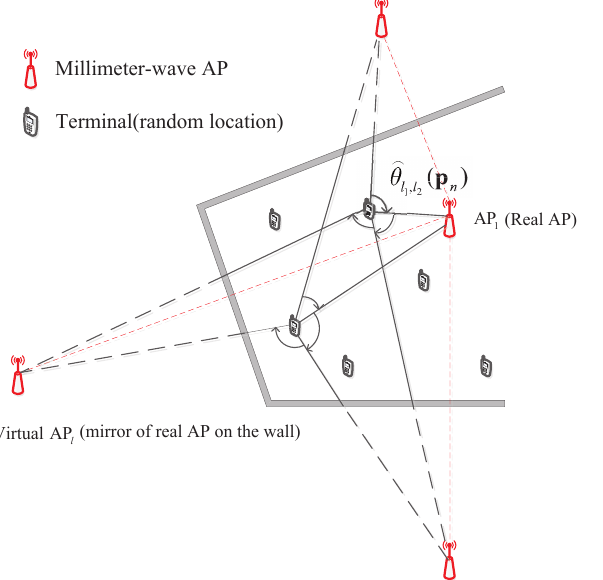
Figure 1. Virtual AP-based mmWave system